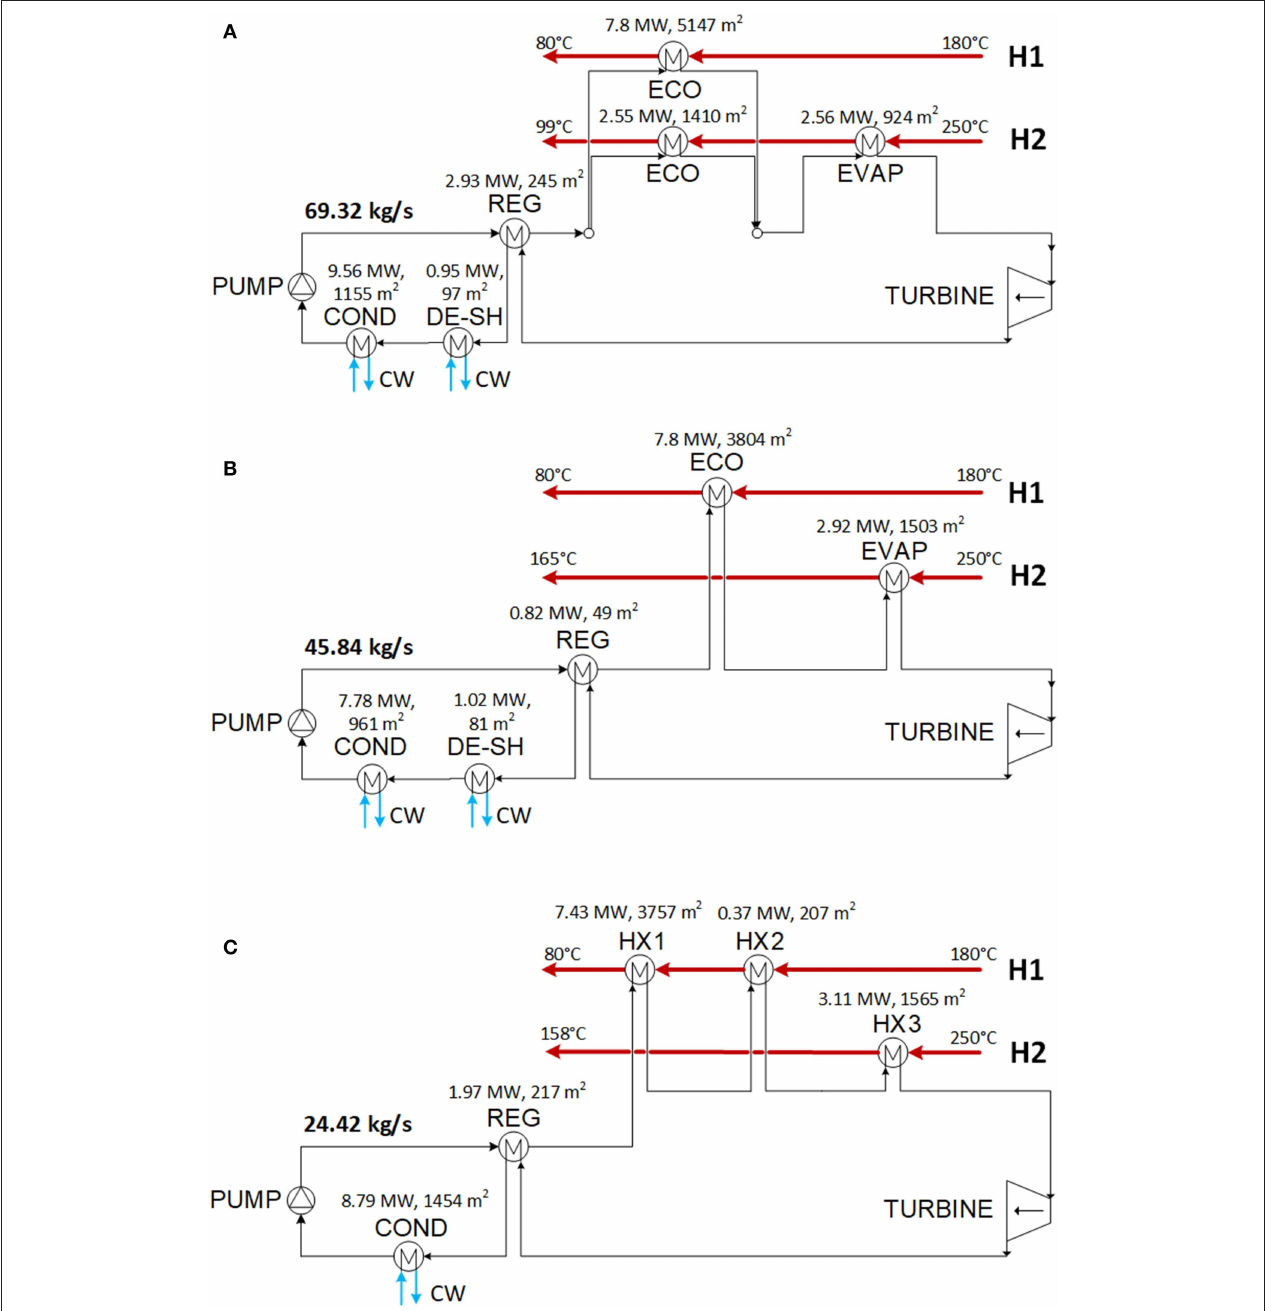
FIGURE 6 | Optimized schemes of the optimal solutions found with fluid RE347mcc (A) , R1336mzz (B) , and isobutane/isopentane mixture (C) for the electricity price equal to 70 $/MWh.